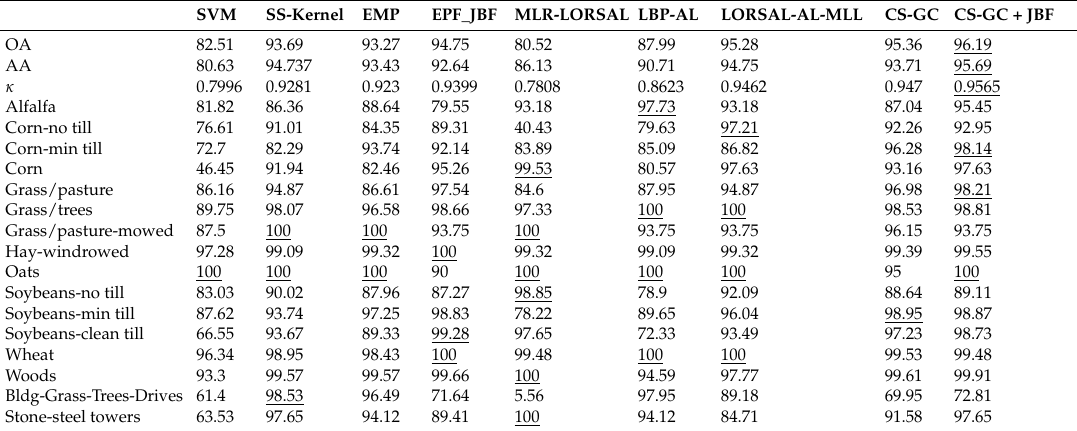
Table 2. The GAs and CAs (percent) for the Indian Pines data set by all the classification methods used in this work for comparison. The highest accuracies are indicated in underlined in each category.